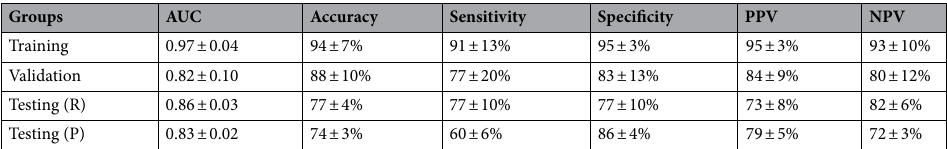
Table 2. Deep learning model prediction of breast pCR in the training, validation, retrospective independent testing, and prospective blinded testing groups. pCR pathological complete response, Testing (R) retrospective